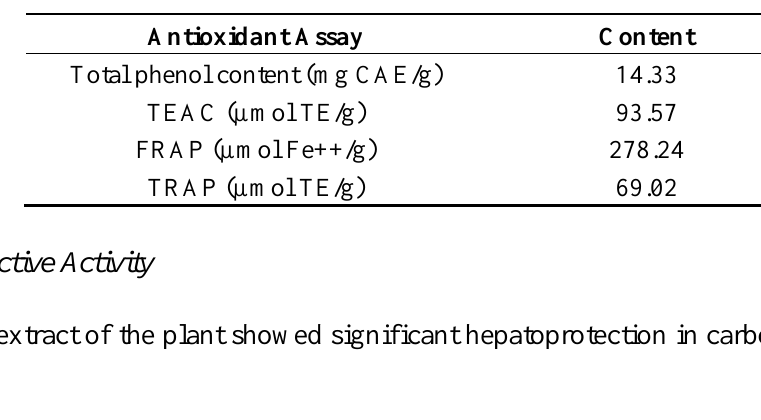
Table 8. Antioxidant activity of I. hederacea